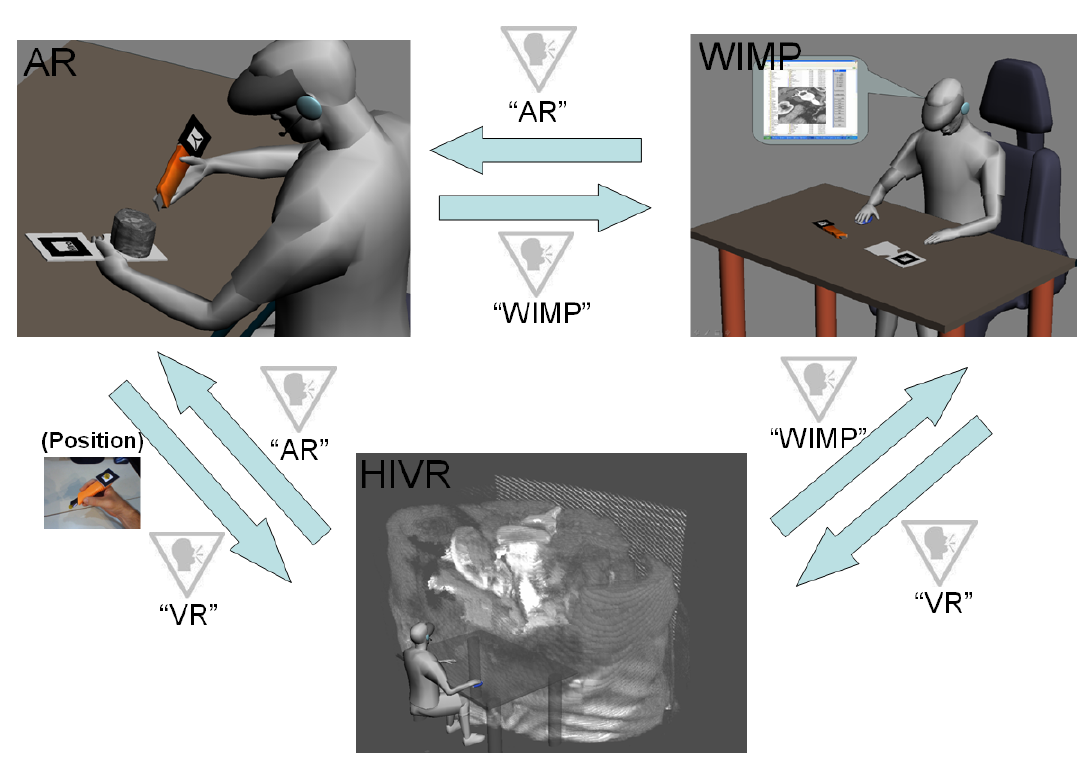
Fig. 6. User’s interaction along the three environments: WIMP, HIVR and AR.